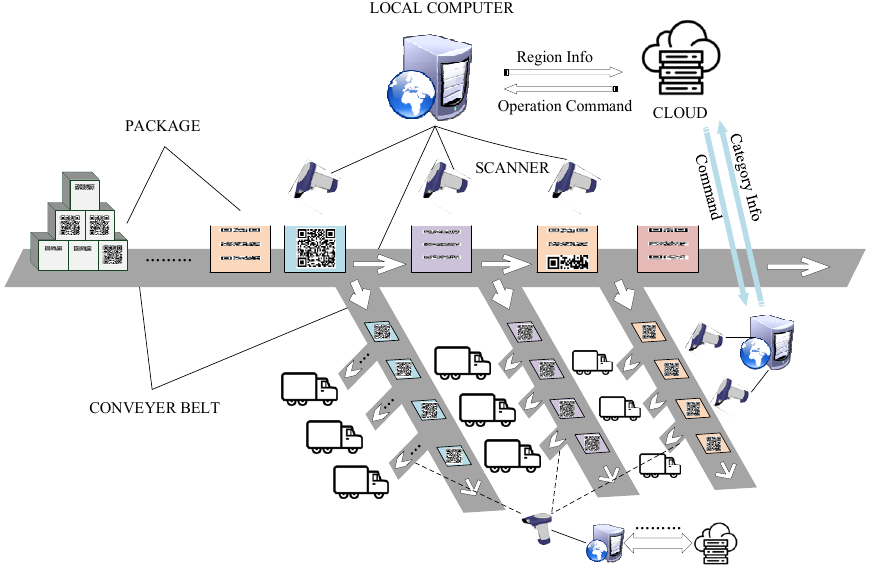
Figure 1. Workflow of automatic sorting in Logistics Systems.